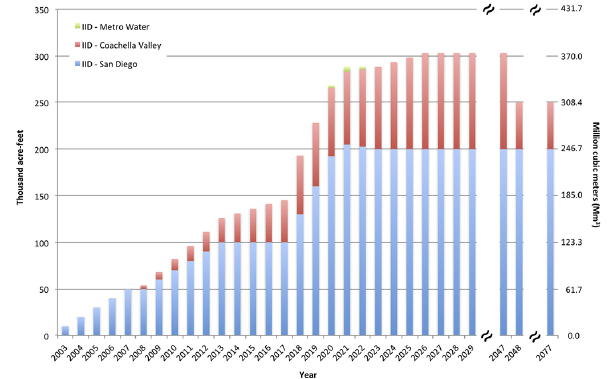
Fig. 3. Limarí Basin – comparison of monthly streamflow (pan- American gauge station) and precipitation (blue bars) (Ovalle station).